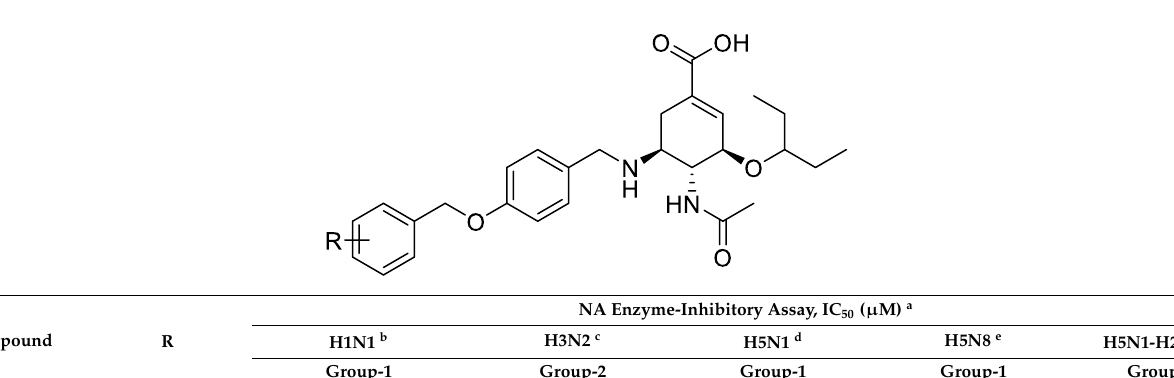
Table 1. Neuraminidase (NA) inhibition of oseltamivir derivatives in chemiluminescence-based assay.